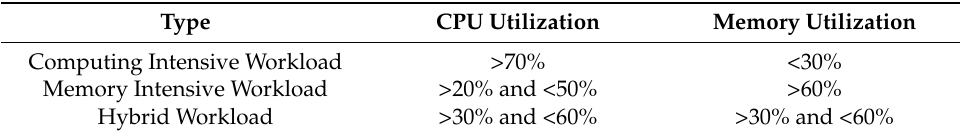
Table 6. Virtual machine (VM) workload type